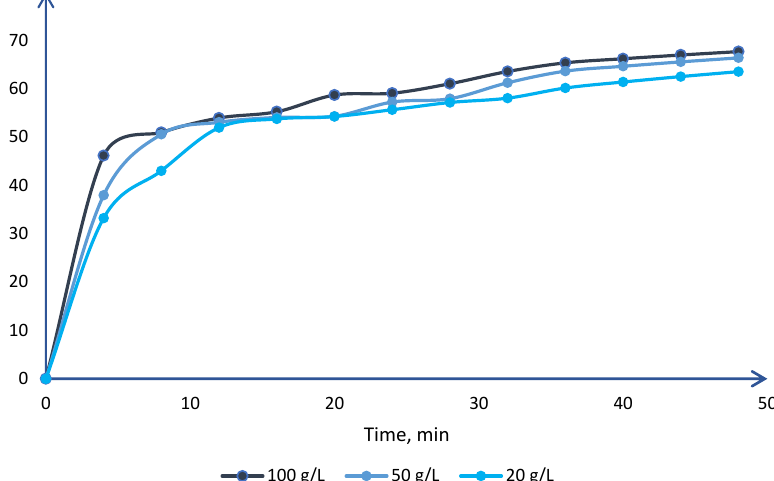
Figure 4. Effect of the chloride concentration in Cu 2 S solution (T = 25 °C, H 2 SO 4 = 0.5 mol/L) (Modi- fied from: [13]).